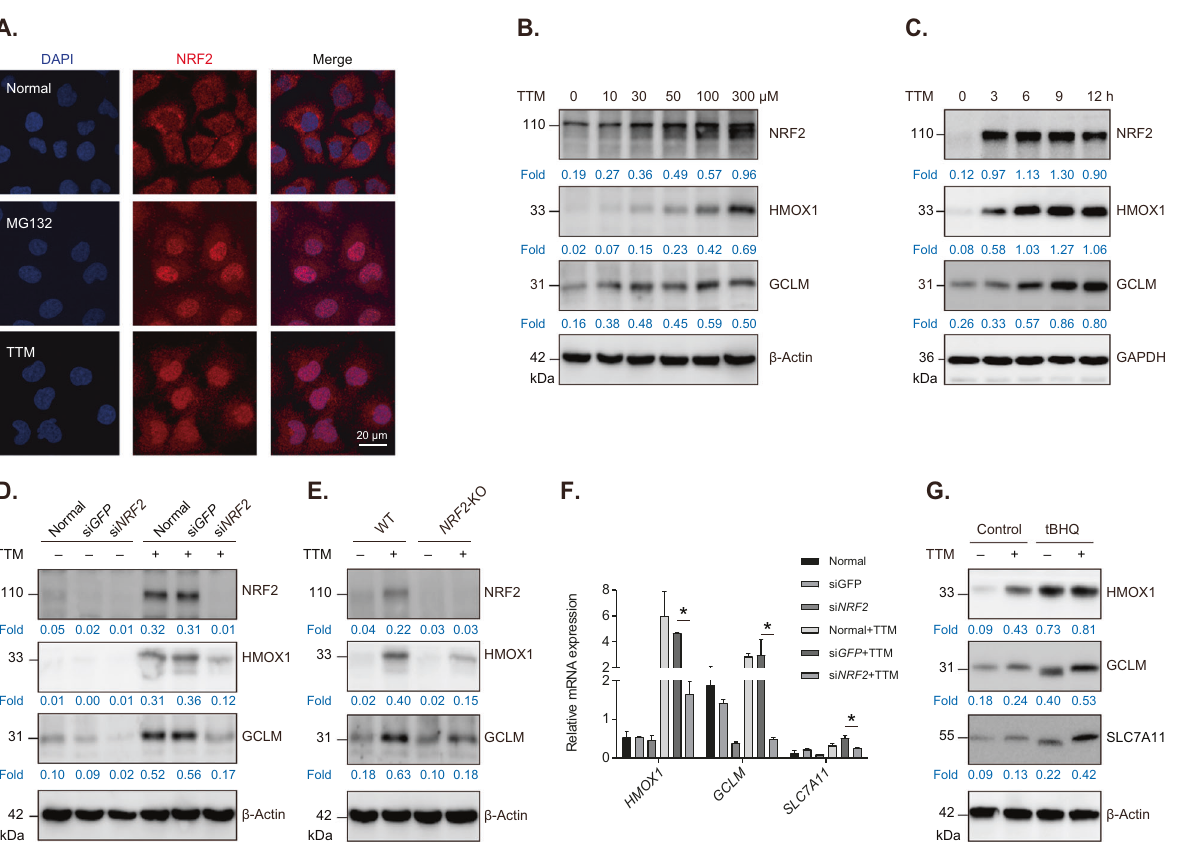
Fig. 1 Copper chelator TTM activates NRF2 antioxidative signaling in HUVECs. A Immuno fl uorescence analysis of NRF2 in HUVECs after treatment with 100 μ M TTM for 12 h. MG132 was used as a positive control. The nucleus was stained with DAPI. Scale bar, 20 μ m. B Western blot analysis and quanti fi cation of NRF2, HMOX1 and GCLM in HUVECs treated with different dose of TTM for 12 h. β -Actin was used as loading control. C Western blot analysis and quanti fi cation of NRF2, HMOX1, GCLM and GAPDH in HUVECs treated with 100 μ M TTM for indicated time. D Western blot analysis and quanti fi cation of NRF2, HMOX1, GCLM and β -Actin (loading control). HUVECs were transfected with si NRF2 or si GFP (control) for 48 h and then treated with 100 μ M TTM for 12 h. E Western blot analysis and quanti fi cation of NRF2, HMOX1, GCLM and β -Actin in TTM-treated normal (WT) or NRF2 knockout ( NRF2 KO) cells. F Quanti fi cation of mRNA levels of HMOX1 , GCLM and SLC7A11 in si NRF2 - transfected cells. One-way ANOVA followed by a Tukey multiple comparison test was used for statistical analysis. * p < 0.05. G Western blot analysis and quanti fi cation NRF2 downstream proteins including HMOX1, GCLM and SLC7A11 in TTM-treated HUVECs with or without 10 µM tBHQ for 12 Quantitative PCR Assay Total RNA was extracted using Eastep ® Super Total RNA Extraction Kit (#LS1040, Promega) and then reversely transcribed into cDNA using Hiscirpt ® II Q RT SuperMix for quantitative PCR (qPCR; + gDNA wiper) Kit (#R233-01, Vazyme, Nanjing, China) according to the manufacturer ’ s instructions. qPCR was performed using ChamQ Universal SYBR qPCR